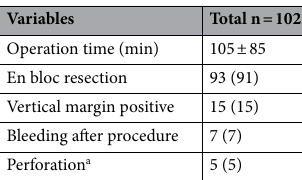
Table 2. Clinical outcomes of ESD for T1b2 gastric cancer. a All cases could be treated by conservative